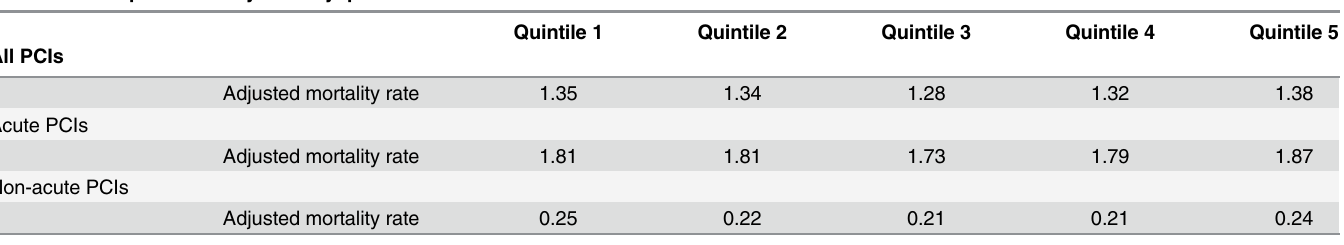
Quintile 1 Quintile 2 Quintile 3 Quintile 5